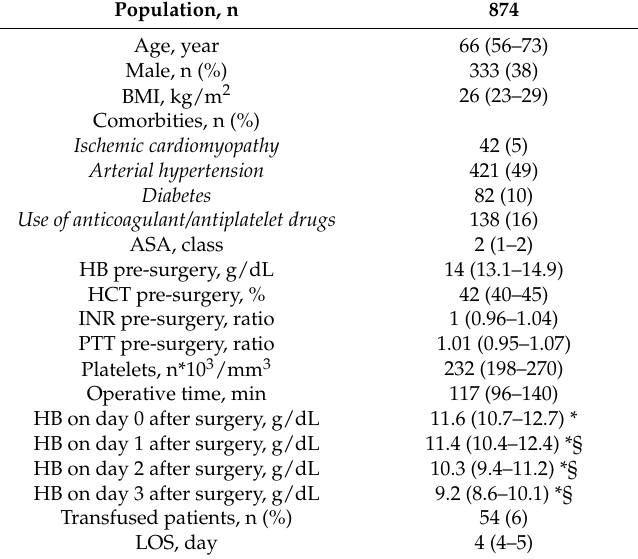
Table 1. Whole population description.